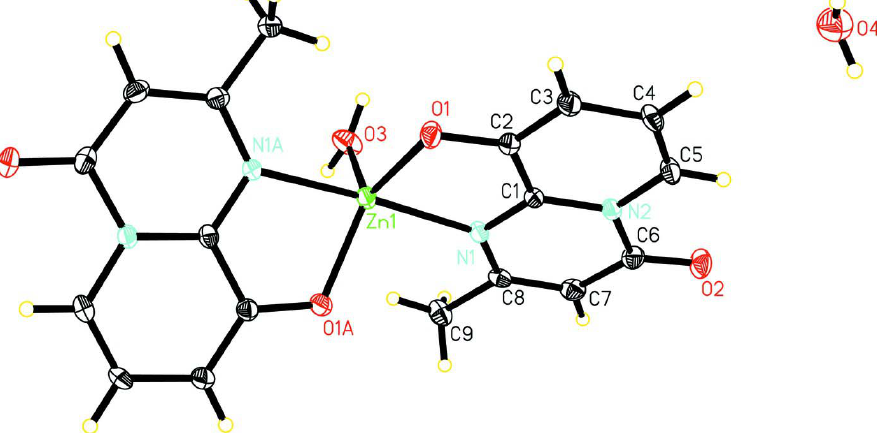
The molecular structure of the title molecule and the atom-numbering scheme. Displacement ellipsoids are drawn at the 30% probability level. [Symmetry code A: - x , y , 0.5 - z